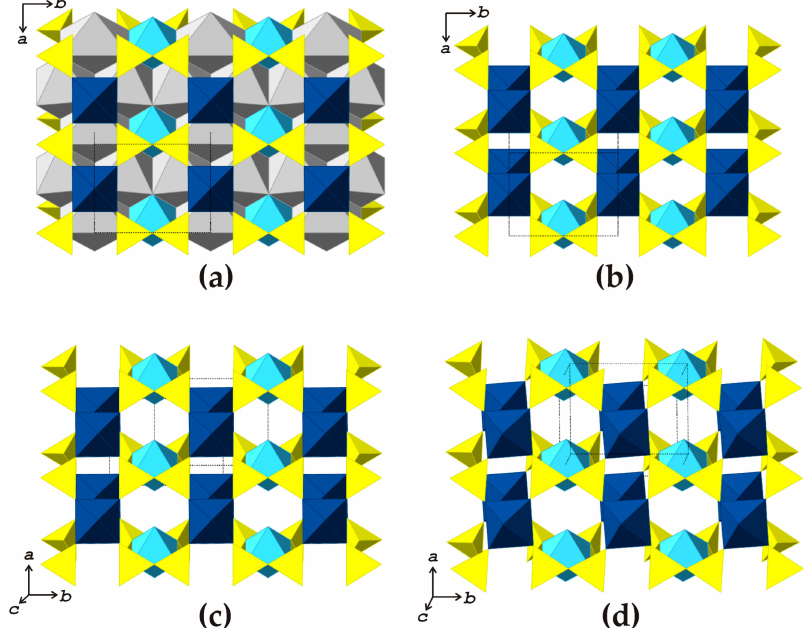
Figure 2. The HOH block in shkatulkalite ( a ); and the HOH blocks in shkatulkalite ( b ); epistolite ( c ) and vuonnemite ( d ) with the NaO 6 octahedra of the O sheets omitted for clarity. Legend: Nb, Ti, Na, and Si polyhedra are shown in dark-blue, light-blue, gray, and yellow colors, respectively.